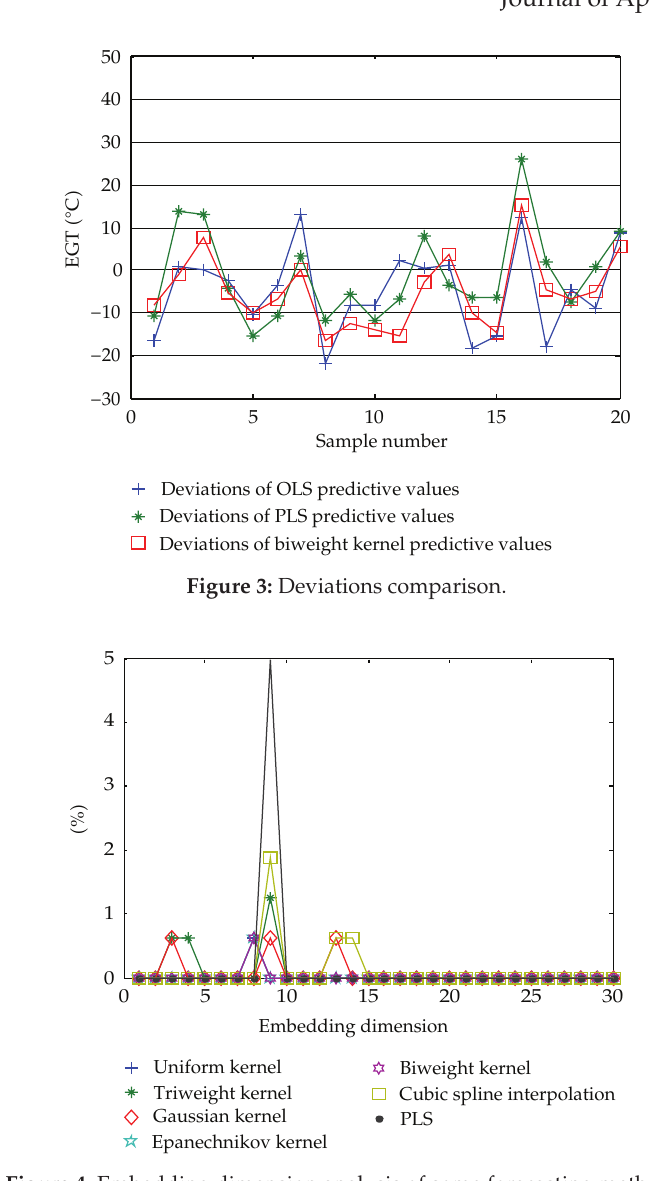
Figure 4: Embedding dimension analysis of some forecasting